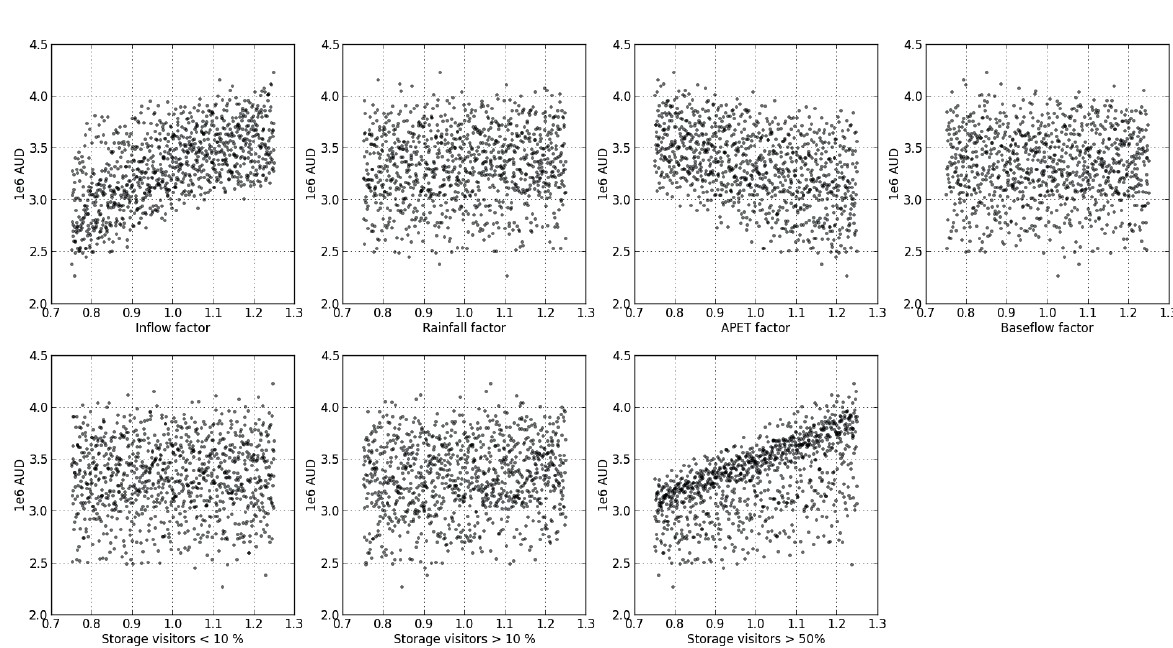
Fig. 4 Scatter plots of sensitivity analysis of the effect of selected driving variables and parameters on the total value generated by recreation on storage reservoirs. Shown on the x -axis are the multipliers with which the original model was